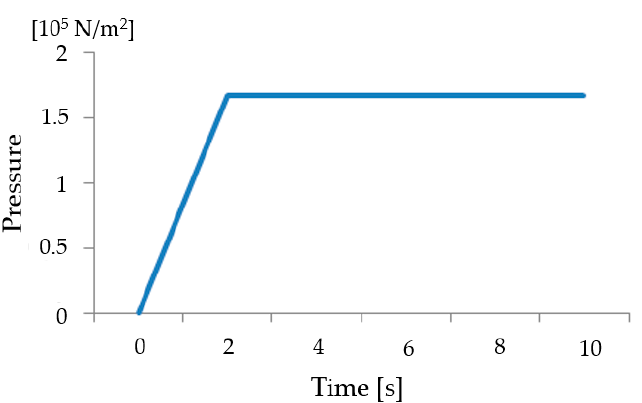
Figure 15. The compressor outlet pressure from the experimental results in relation to time .